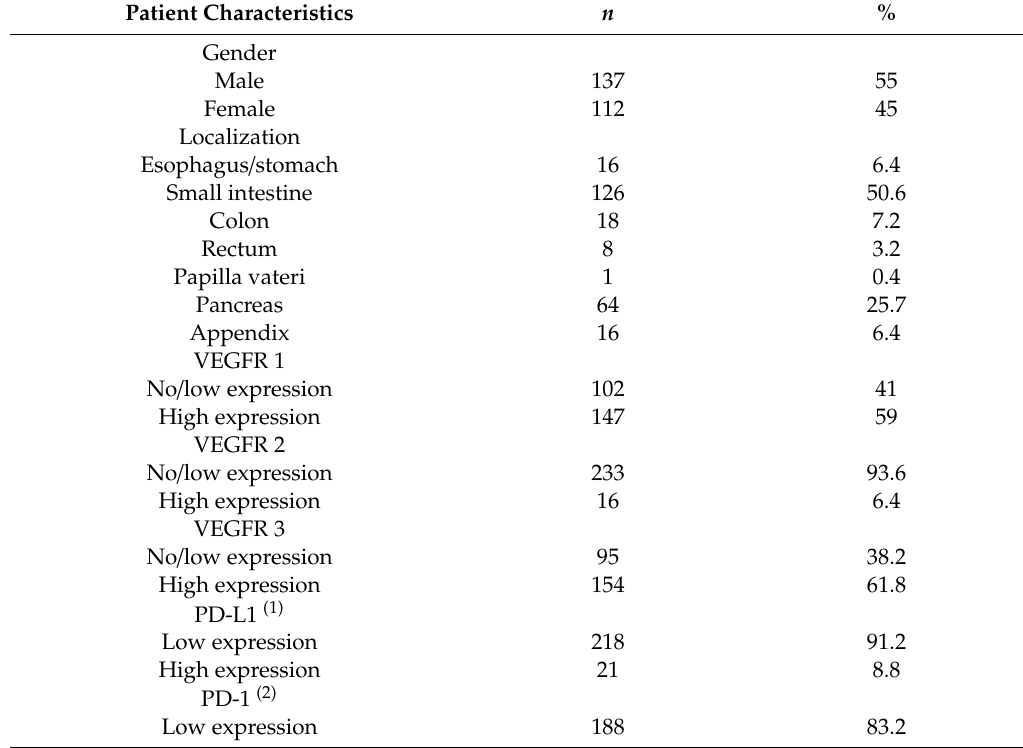
Table 1. Baseline characteristics in 249 patients with gastroenteropancreatic neuroendocrine neoplasms (VEGF: Vascular endothelial growth factor receptor; (1) 10 missing, (2) 23 missing, (3) 5